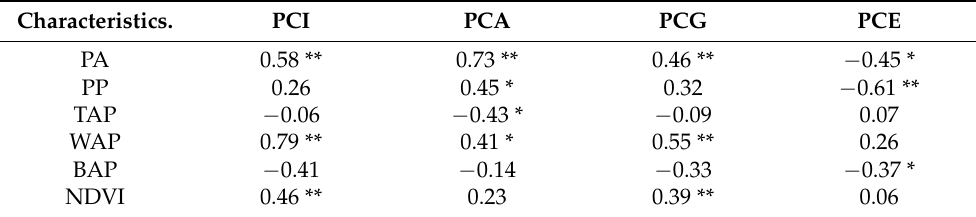
Table 5. The correlation coefficients for urban park features and the park cooling island.